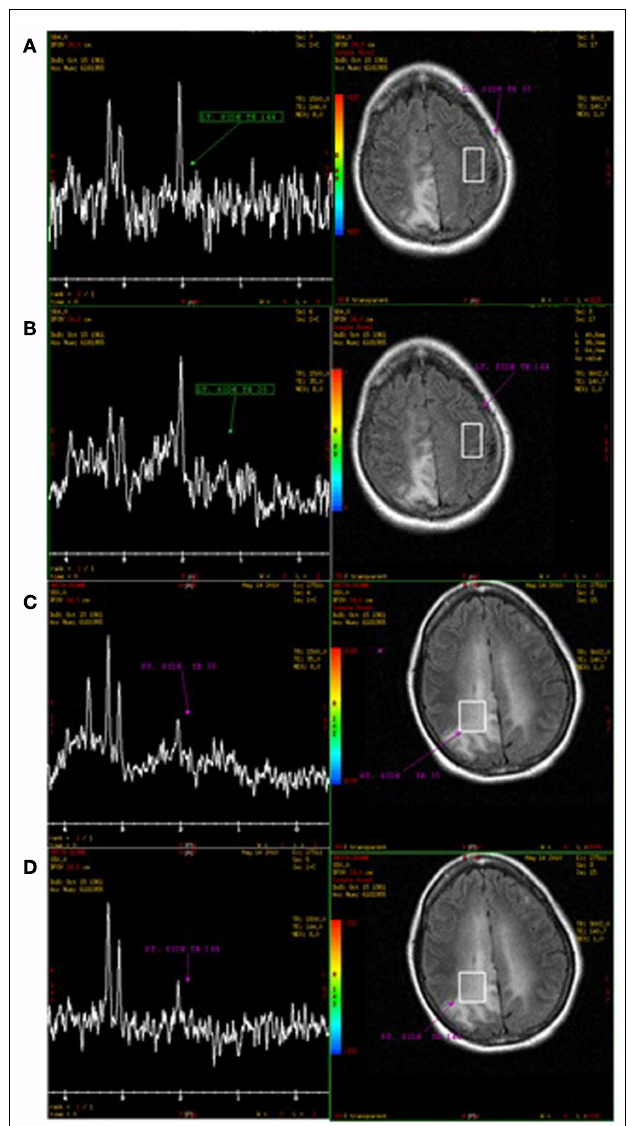
FIGURE 2 | MR spectroscopy of a right parietal lobe abnormality (C,D) demonstrate decrease in the N -AcetylAspartate peak (NAA) and elevation of the choline peak. There is no lactate peak.While not specific, these changes could be consistent with diffuse neuronal loss and increase cellular turnover. (A,B) Normal parenchyma on the left parietal lobe as control.